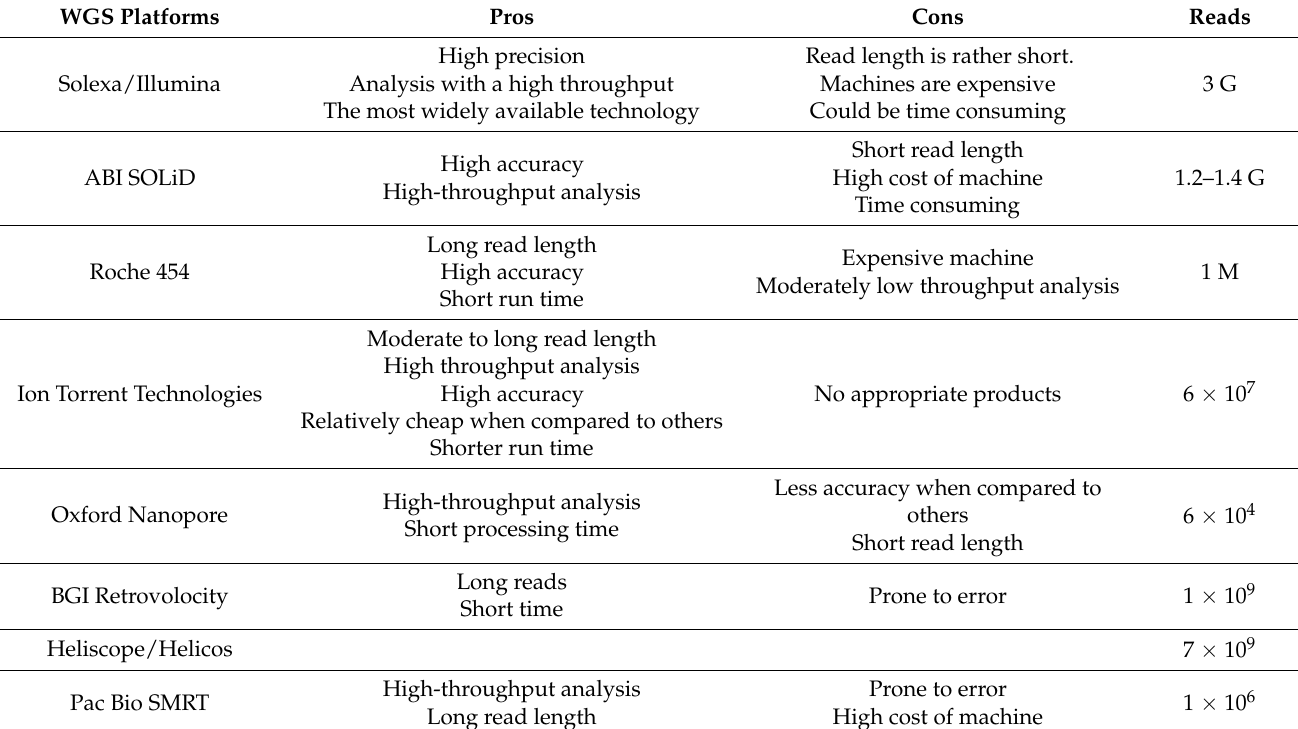
Table 1. Characteristics of different whole genome sequencing